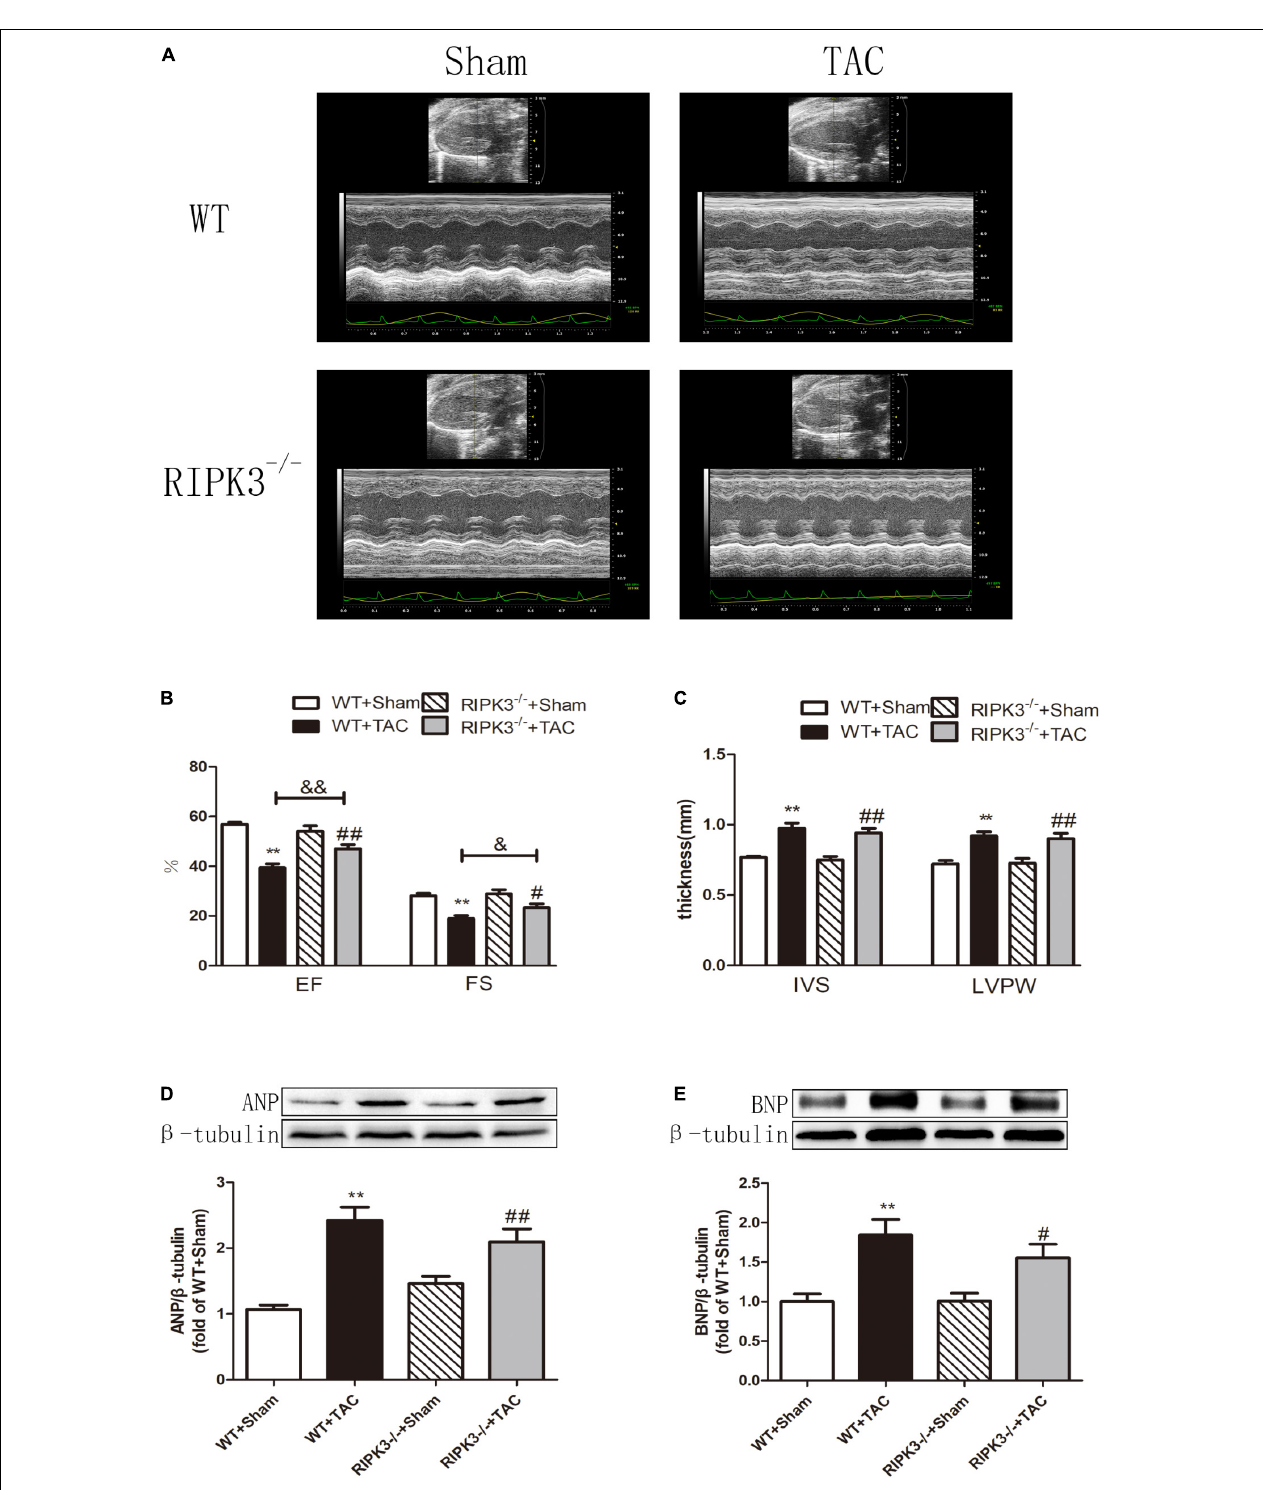
FIGURE 3 | Depletion of RIPK3 can alleviate cardiac insufficiency in mice with HF and has no significant improvement in the increased expressions of ANP and BNP. Male 8-week-old WT and RIPK3 − / − mice were treated with TAC using a 28-g needle. The control group received sham surgery. All groups of mice were given continuous feeding for 6 weeks. Hearts were then obtained for correlative testing. (A) Echocardiography. (B) EF and FS. (C) IVS and LVPW. (D) The expression of ANP at the protein level in myocardial tissue was detected by Western blotting analysis, and β -tubulin was used as a loading control; (E) The expression of BNP at the protein level in myocardial tissue was detected by Western blotting analysis, and β -tubulin was used as a loading control. Compared with WT + sham group, ** P < 0.01; compared with RIPK3 − / − + sham group, ## P < 0.01 and # P < 0.05; compared with WT + TAC group, && P < 0.01 and & P < 0.05. n = 6.